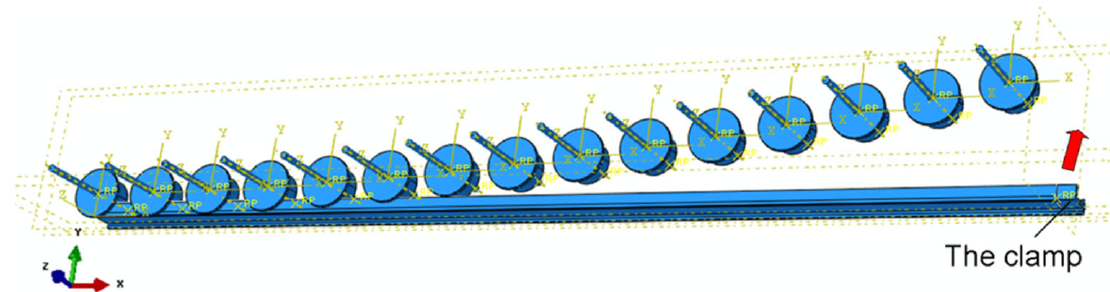
Figure 5. The assembly drawing.